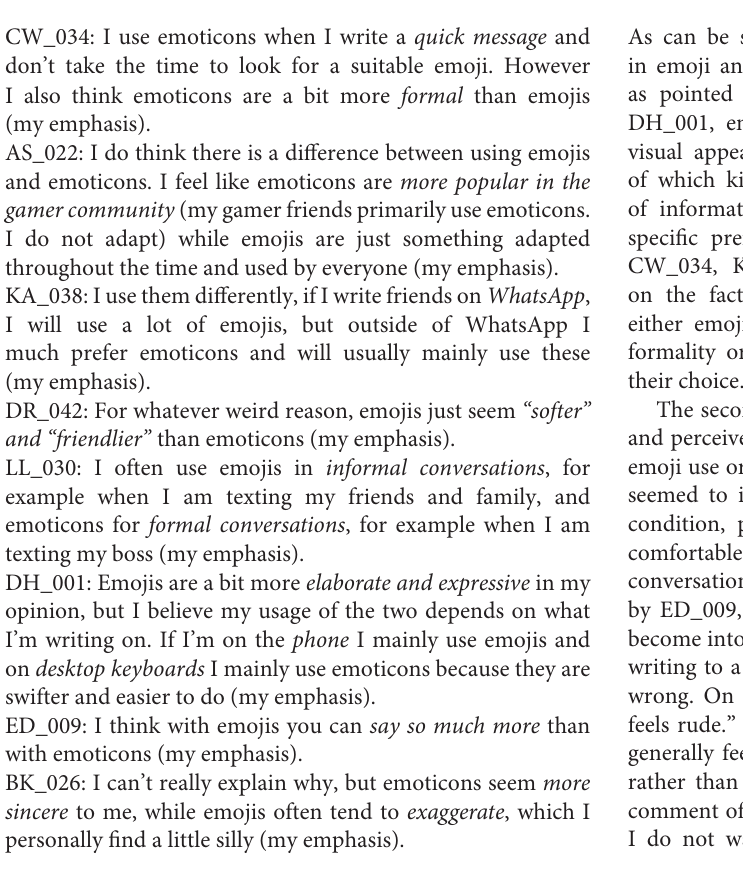
FIGURE 5 | (Left): Similarity map based on Jaccard’s Coefficient in the emoji condition, relying only on emoji functions and the specifics of use (strings, compositions, stand-alone). The distance between the individuals’ text excerpts reflects the respective degrees of similarity. (Right): The closer the result is to 1, the more similar the parts of the chats are to each other. Gray indicates “correct”